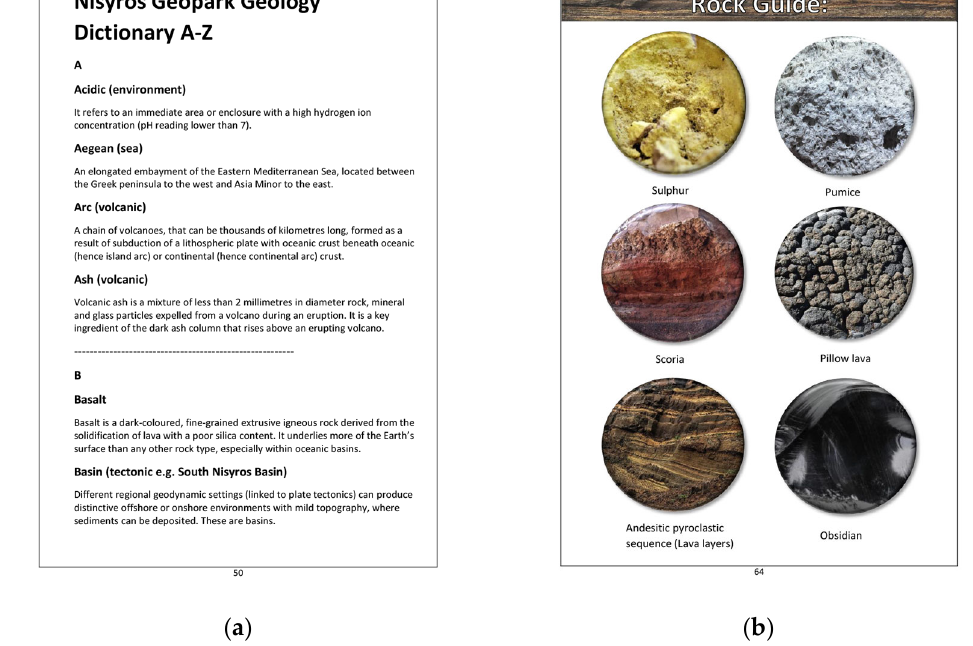
Figure 18. Examples of the content of the guidebook: ( a ) The first page of the dedicated section to the A-Z geological dictionary, also present within the ‘Nisyros Volcano App’; ( b ) The Rock Guide at the end of the guidebook.